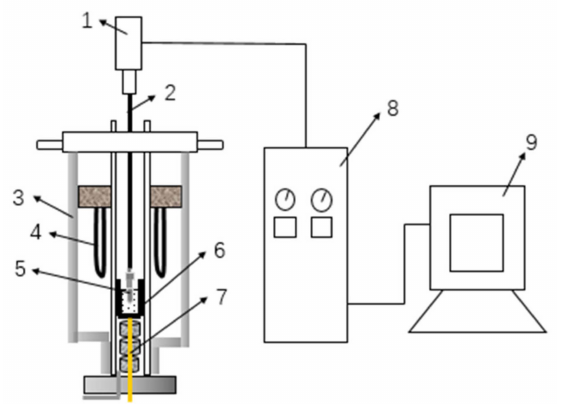
Figure 1. Schematic diagram of the viscosity test. 1-torque sensor 2-corundum rod 3-furnace 4-silicon molybdenum heating element 5-molybdenum rotor 6-graphite crucible 7-thermocouple 8-control panel